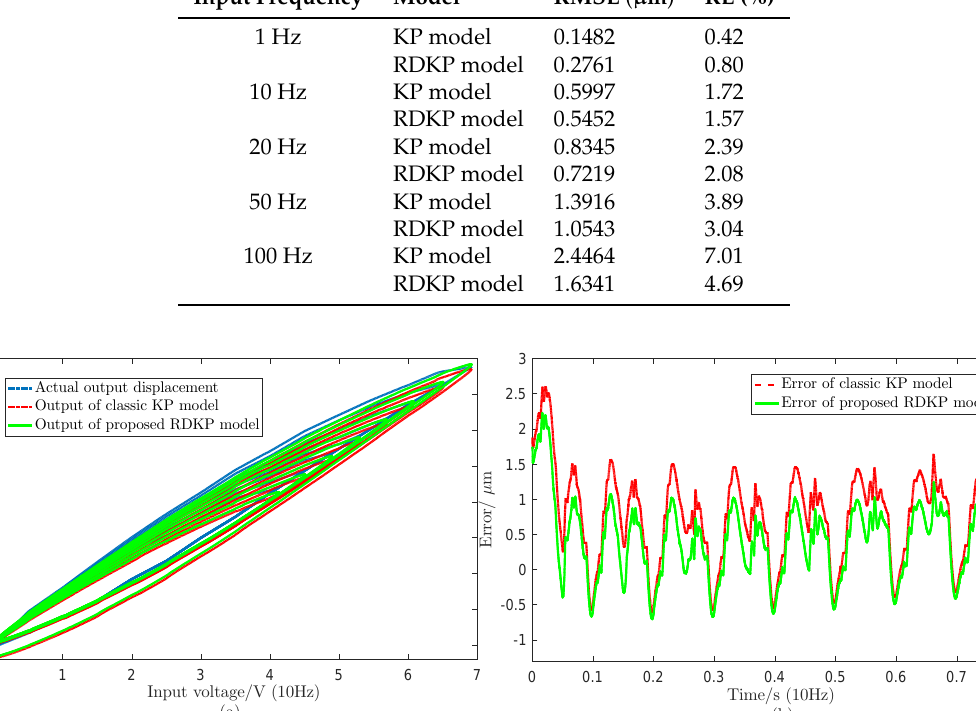
Figure 11. The experiment results of the proposed RDKP model and classic KP model under sinusoidal signal with damping amplitude input voltage, including ( a ) minor hysteresis loops of input voltage and output displacements and ( b ) modeling errors of the proposed RDKP model and classic KP